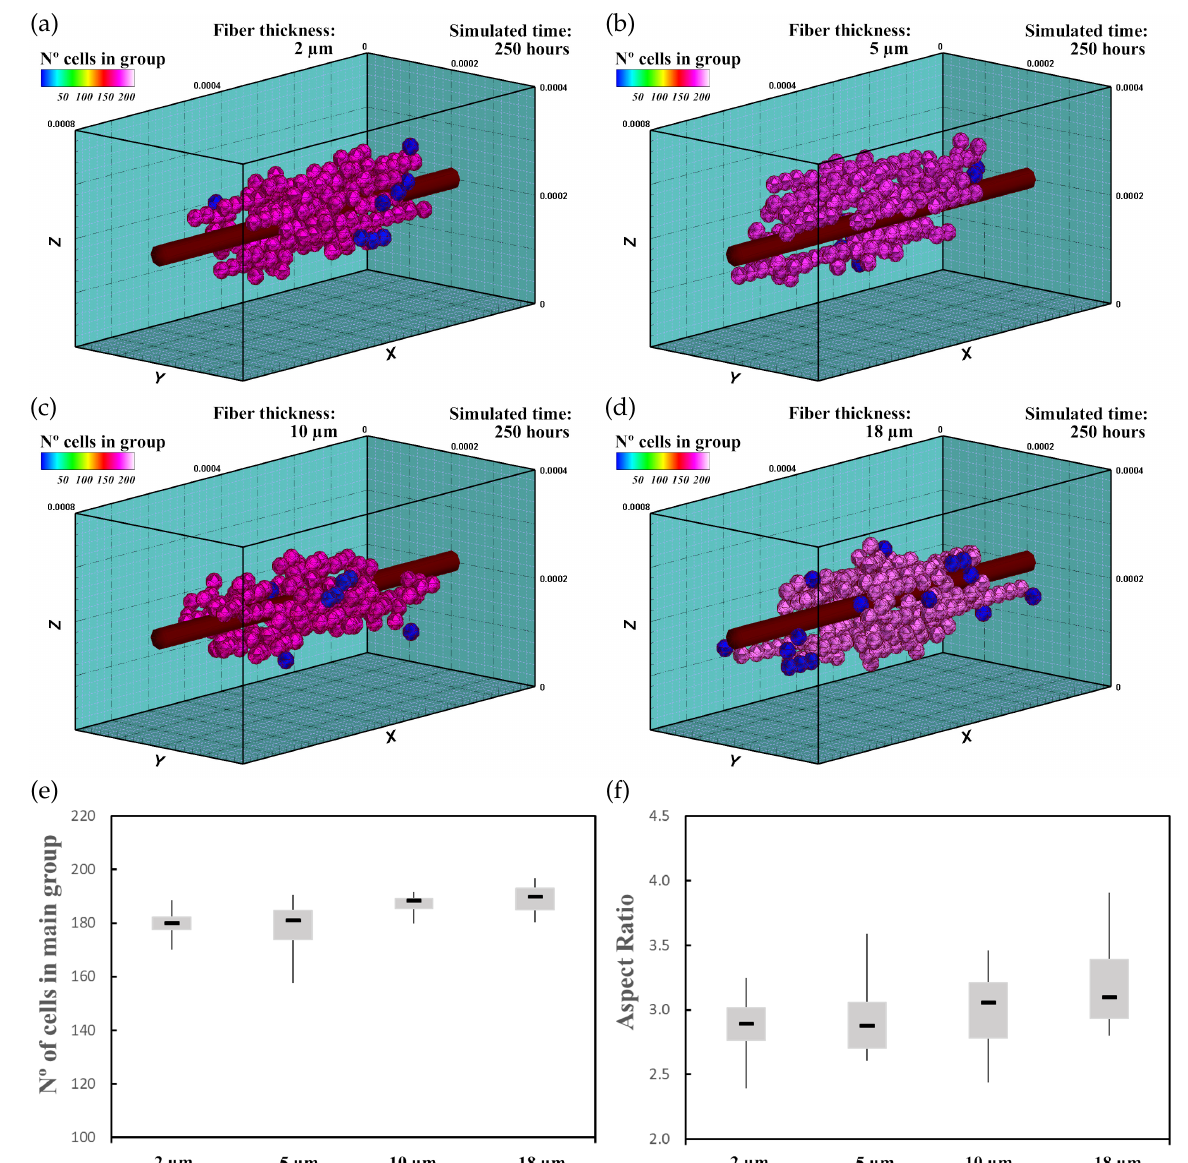
Figure 9. Group morphology and number of cells corresponding to an ECM with a central fiber thickness of 2 µ m ( a ), 5 µ m ( b ), 10 µ m ( c ), and 18 µ m ( d ). Cells are simulated in a deformed ECM where the passive deformation of the ECM is not considered on the cell deformation. Cells tend to migrate towards the central fiber where elongated groups are formed (see also Supplementary Material: S3). ( e ) Numerical results of the number of cells in the main group. ( f ) AR of the main